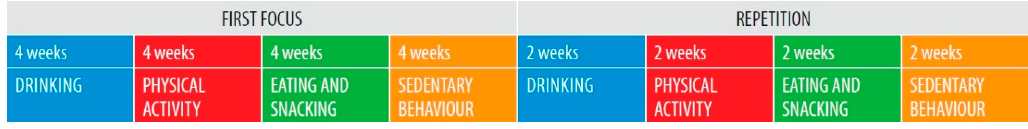
Figure 1. Flow of the 24-week ToyBox intervention.